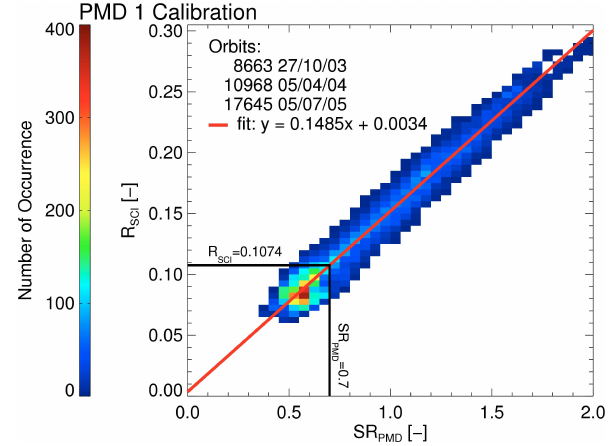
Fig. 1. Calibration of the SCIAMACHY Polarisation Measurement Device number 1 (PMD 1) signal, covering the spectral region 310–365nm based on three orbits (see annotation). SR PMD is the uncalibrated normalised PMD 1 signal divided by the cosine of the solar zenith angle (SZA). R SCI is the mean reflectivity (sun- normalised radiance divided by the cosine of the SZA) as measured by SCIAMACHY in a spectral region which corresponds to the spectral region covered by PMD 1. The linear fit shows that the PMD 1 based cloud detection criterion SR PMD =0.7 corresponds to R SCI